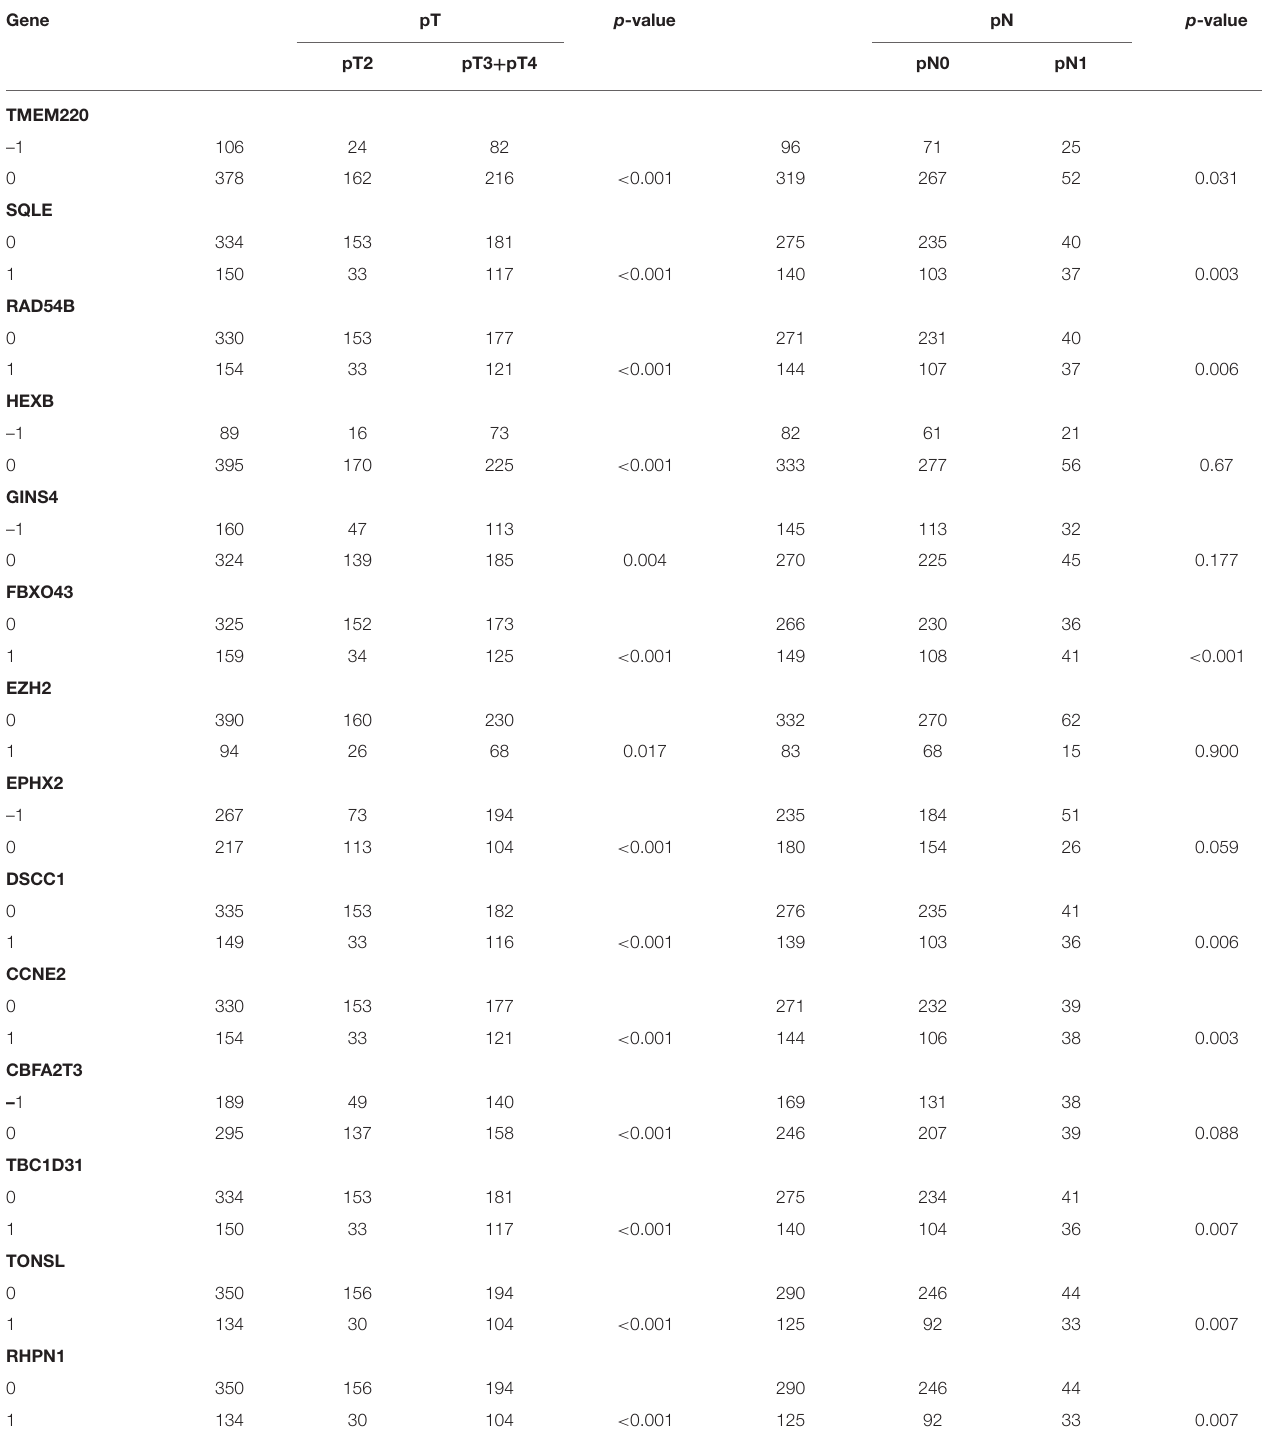
TABLE 1 | Gene copy number variation associated with PRAD clinicopathological staging.